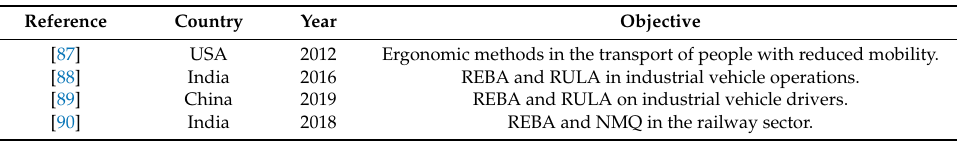
Table 6. Transportation and